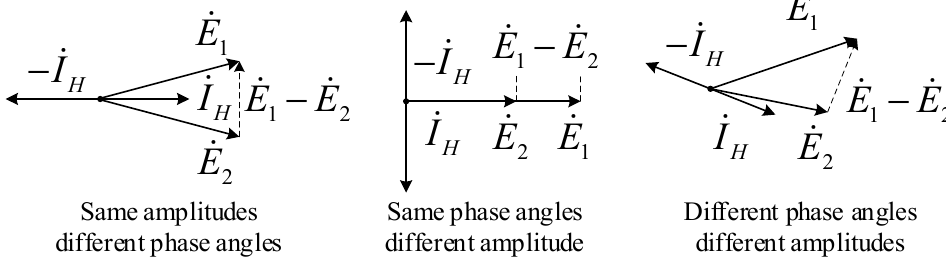
Figure 5. Output voltage and circulating current of parallel systems when output impedance is inductive.